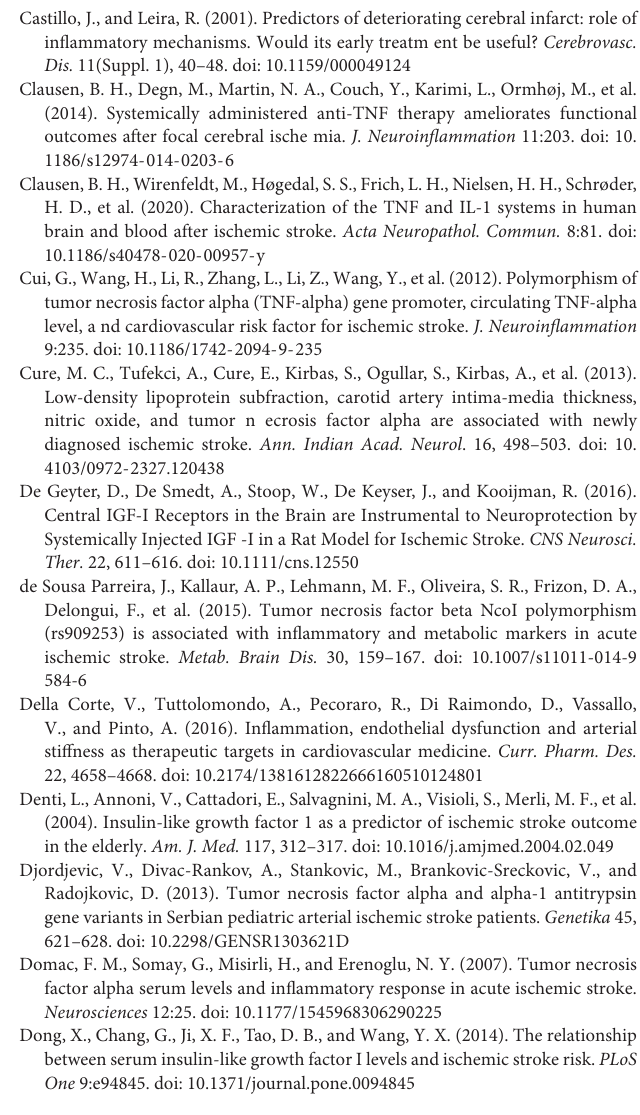
Supplementary Figure 1 | The result of publication bias between the allele of TNF- α (G:A) and IS. Supplementary Figure 2 | The result of publication bias between IGF-1, TNF- α , and IS. (A) The result of publication bias between IGF-1 and IS and (B) the result of publication bias between TNF- α and